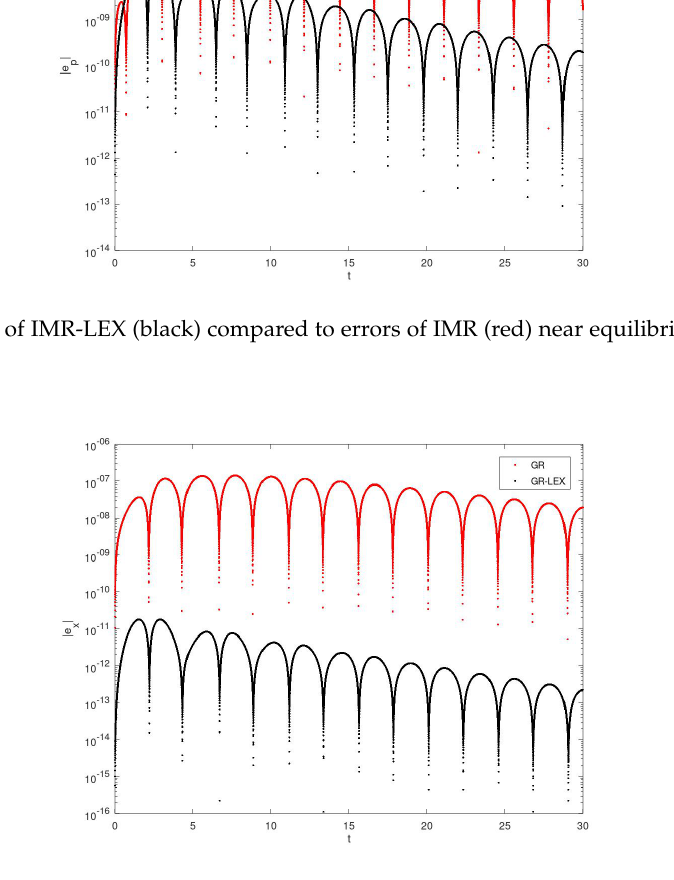
Figure 4. Errors of GR-LEX (black) compared to errors of GR (red) near equilibrium: x 0 = 1/ p 0 = 0.05.